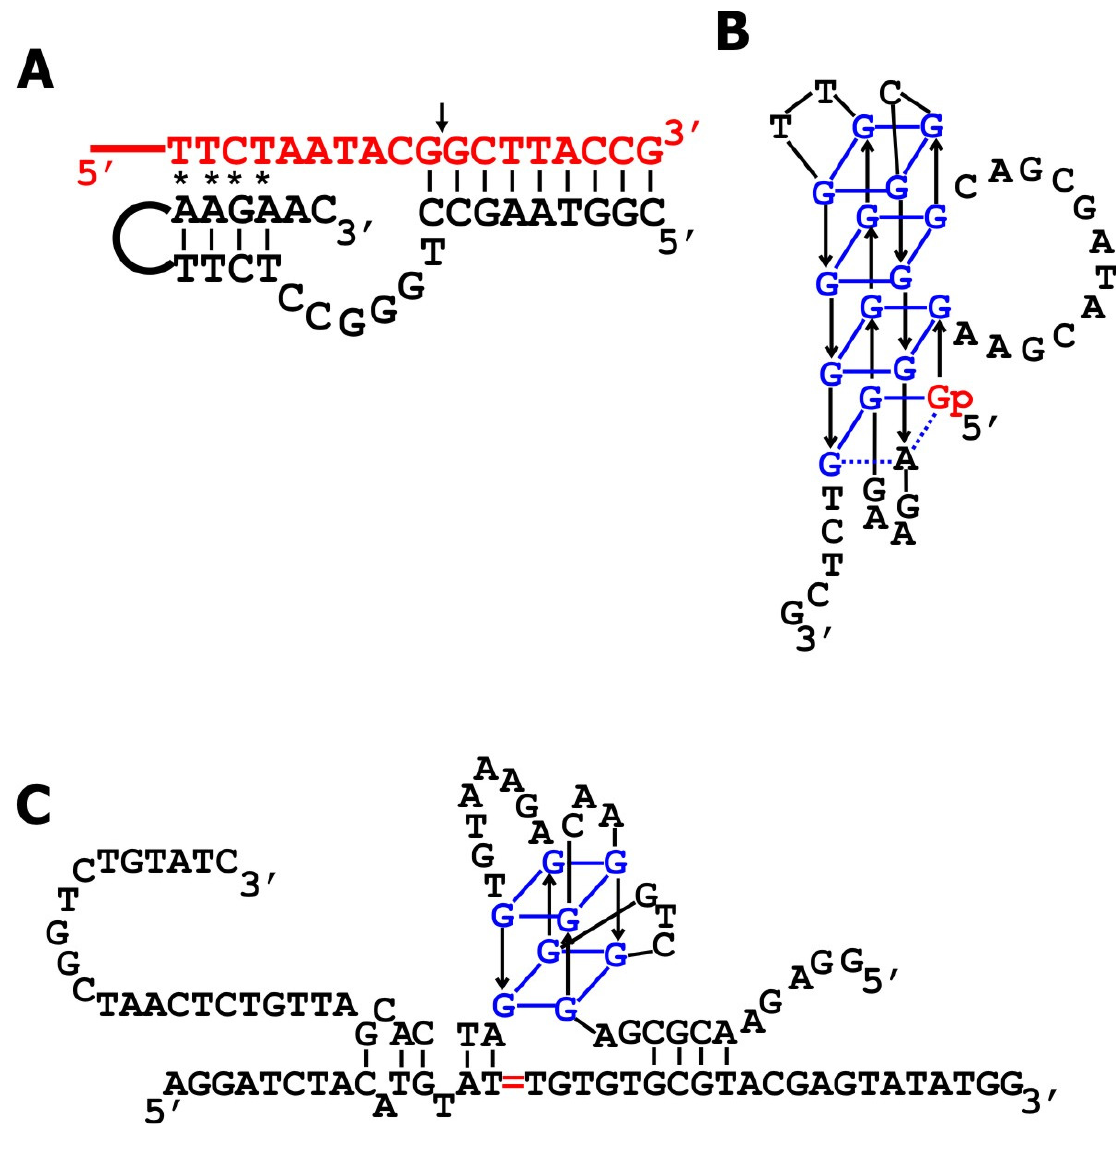
Figure 3. Deoxyribozymes with tertiary interactions. (A) Structural model of a DNA- cleaving deoxyribozyme utilizing a triplex structure. The substrate is shown in red and the cleavage site indicated by an arrow. (B) Structural model of the class I self-capping deoxyribozyme containing a multi-tiered guanine quadruplex. Guanines involved in quadruplex interactions are shown in blue. Gp represents a 5 ′ phosphoryated guanine. (C) Structural model for the UV1C thymine dimer repair deoxyribozyme containing a two- tiered guanine quadruplex. Red parallel lines represent the thymine dimer (the thymines within the dimer are not connected by a phosphodiester bond). The quadruplex is thought to act as a light-harvesting antenna facilitating the repair of the T-T